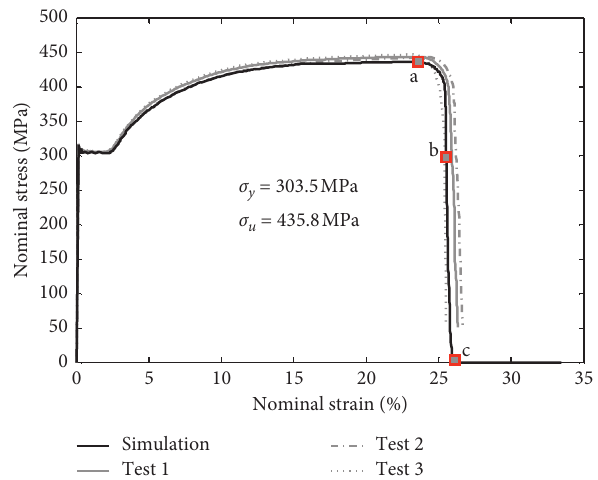
Figure 8: A comparison of simulated and recorded stress-strain